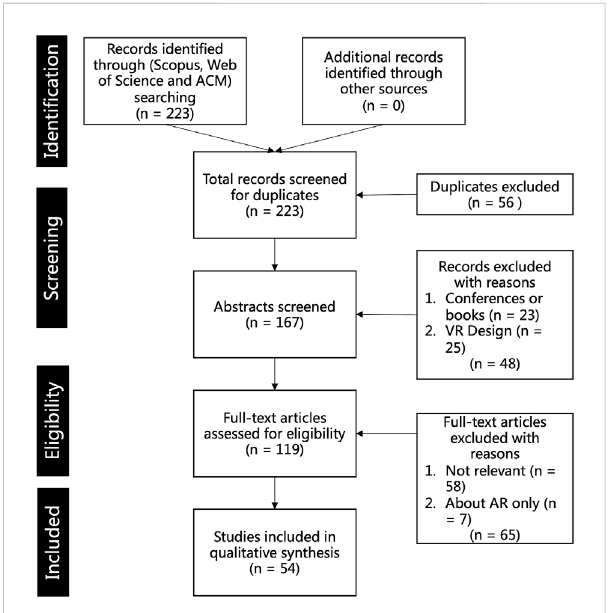
FIGURE 1 4-step PRISMA fl owchart of this literature review based on included, eligibility, screening, and identi fi